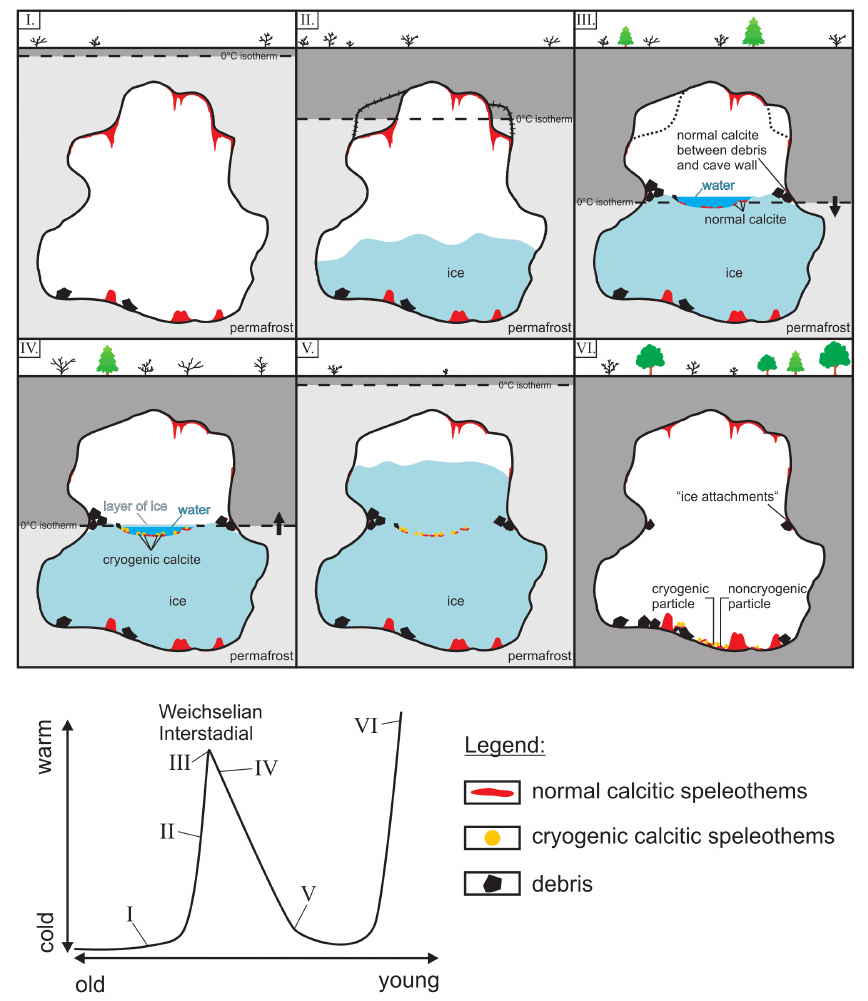
Fig. 9. Cartoon illustrating proposed succession of events that lead to the formation of cryogenic and non-cryogenic calcites during a Weichselian interstadial. Refer to schematic temperature evolution in lower left inset. See text for